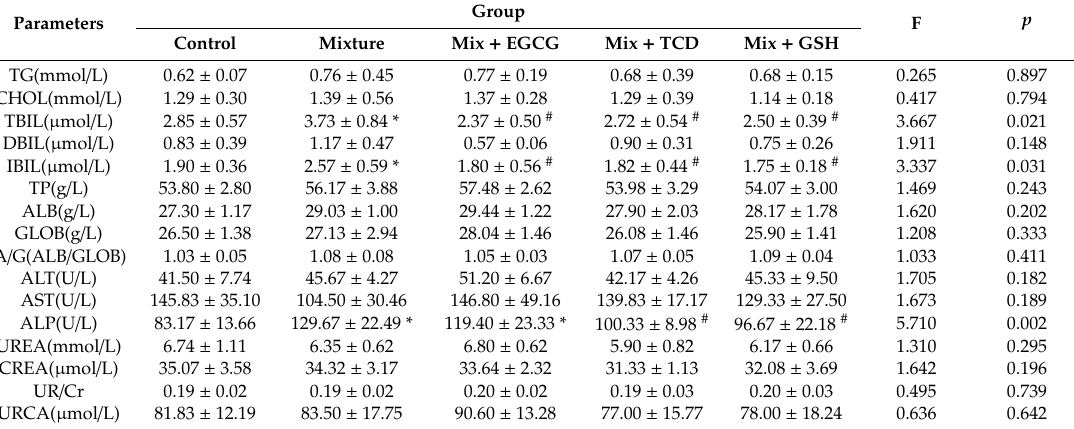
Table 5. E ff ects of the heavy metal mixture on serum biochemical indices with or without the addition of chemical antagonists ( n =